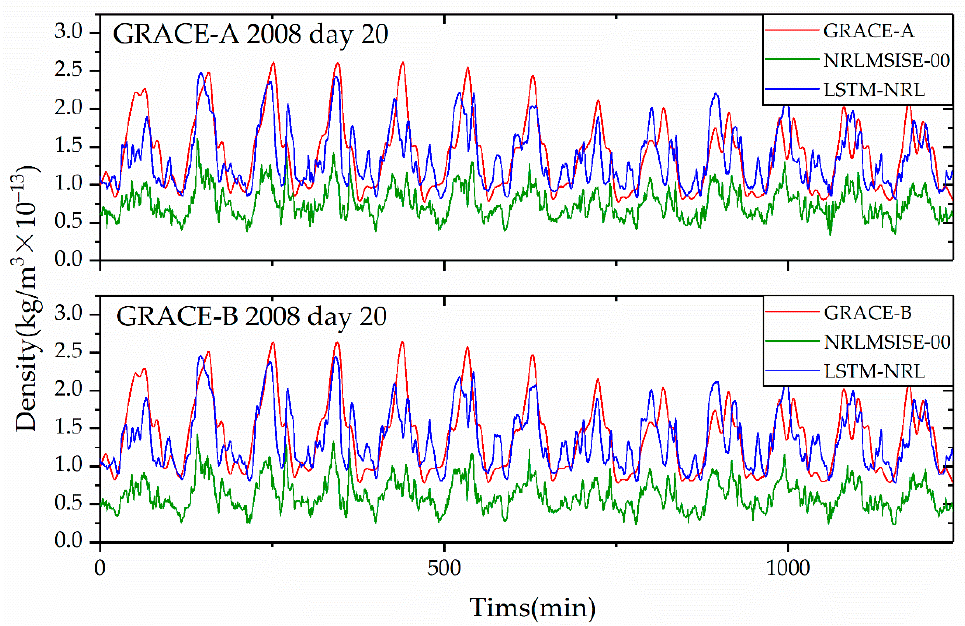
Figure 9. The density series along the GRACE orbits on day 20 of 2008. Table 9. The RMSE and R of the density series along the orbits of three satellites in January 2008. It is noted that the best results, in terms of RMSE and R , are bold in the